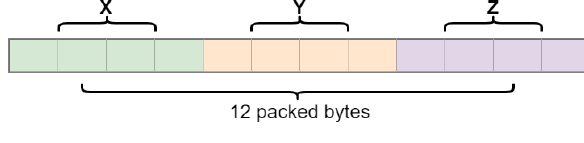
Figure 4. Example of packed bytes.